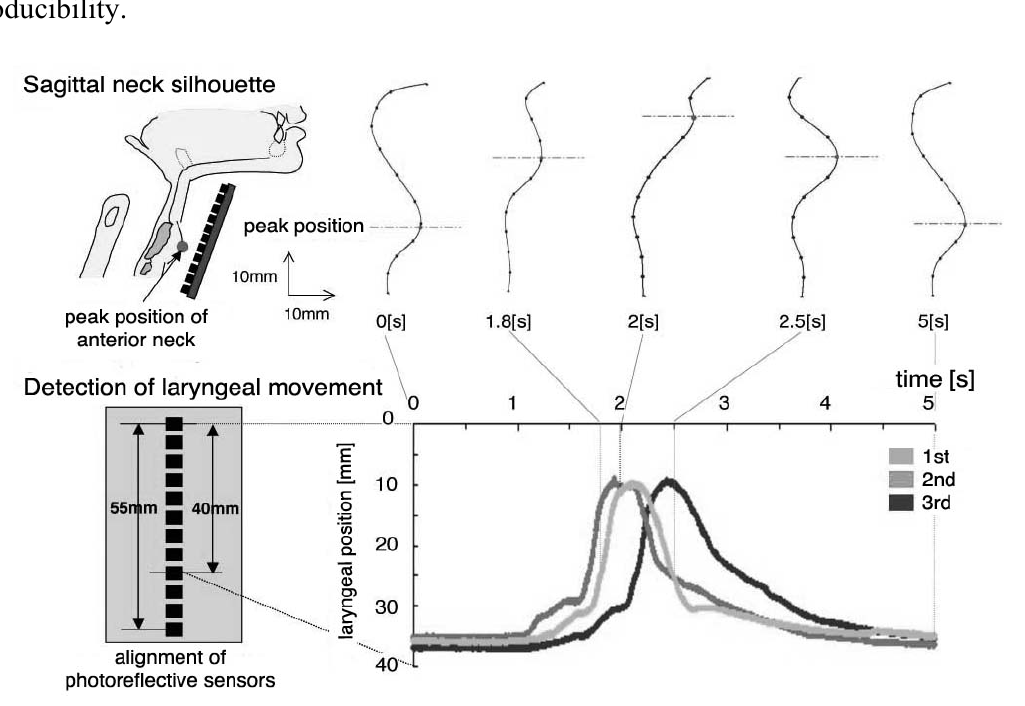
Figure 22. Sagittal neck-silhouette measurement using the laryngeal movement detector of SFN -2 [63,64] and automatic detection of laryngeal movement. Laryngeal position was defined as the position of the peak of the skin surface, and could be tracked automatically. Three trajectories of the same subject are depicted to demonstrate waveform